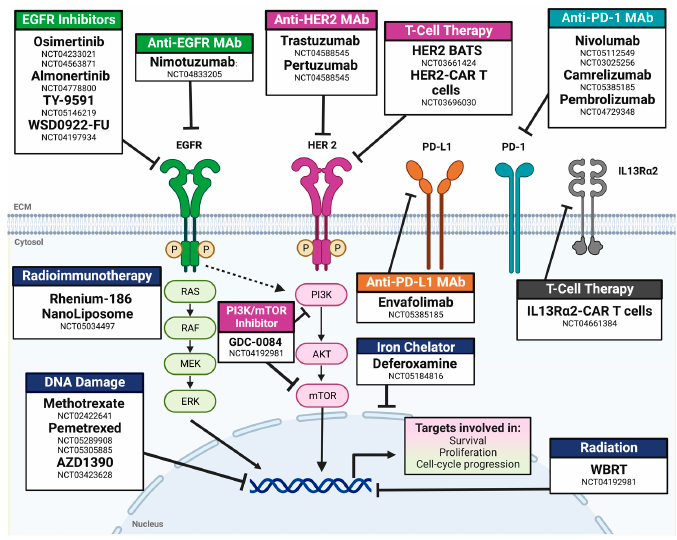
Figure 3. Mechanisms of action for drugs for actively enrolling clinical trials for leptomeningeal carcinomatosis. Abbreviations: Mab: monoclonal antibody; BATS: bi-armed activated T-cells; RT: radiotherapy; WBRT: whole-brain radiotherapy. NCT number: ClinicalTrials.gov identifier.